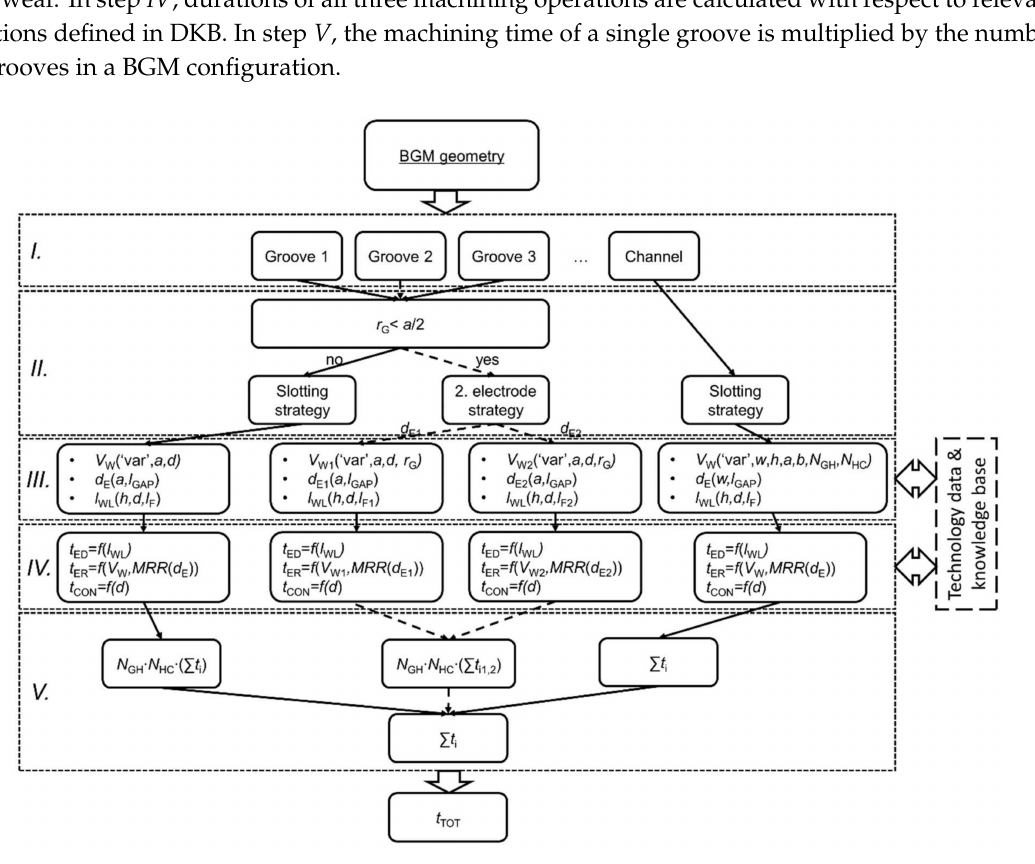
Figure 7. Detailed scheme of the implemented technical model where ‘var’ in dashed box III. denotes either SG or SH